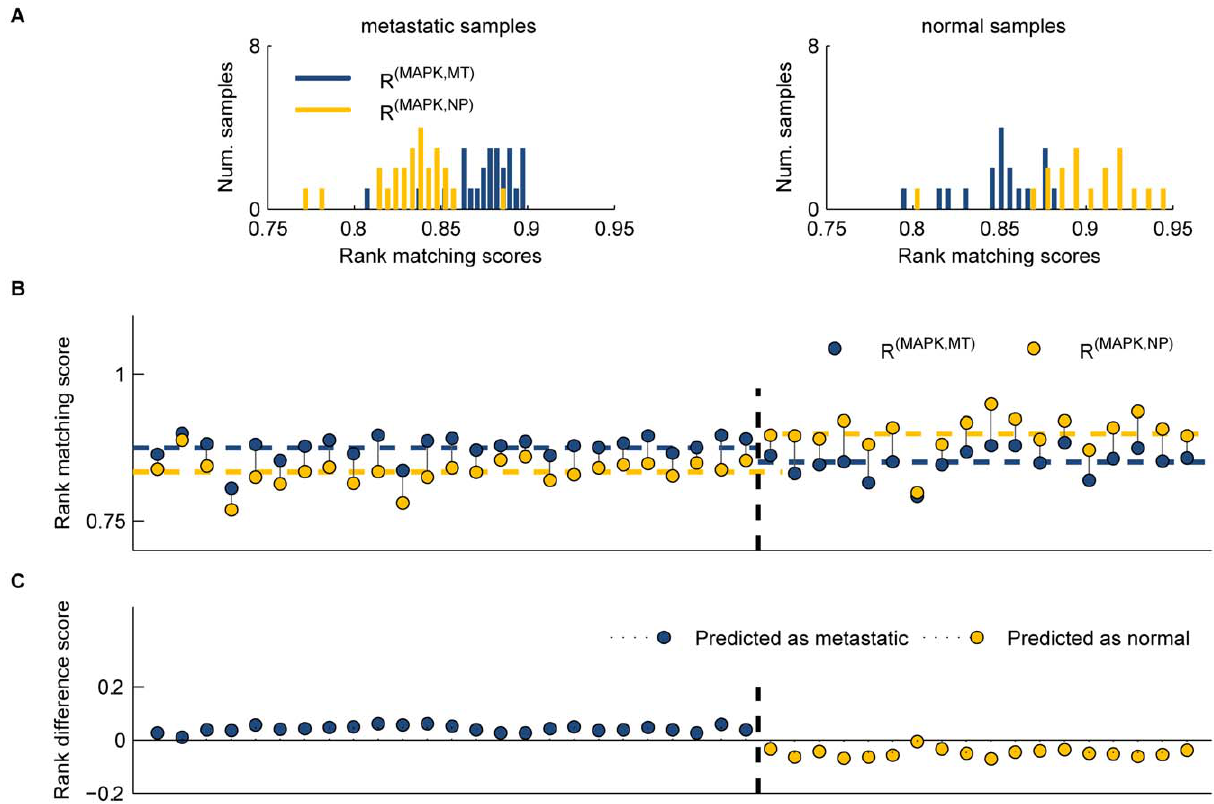
Figure 7. Differential rank conservation of the MAPK network in metastatic prostate cancer and normal prostate. ( A ) Histograms of rank matching scores. MT template matching scores ( R (MAPK,MT) ) are higher on average in MT samples than NP matching scores ( R (MAPK,NP) ). In NP samples, R (MAPK,NP) scores are higher on average than R (MAPK,MT) scores. ( B ) Rank matching scores for the MAPK network. Comparing the two rank matching scores in each sample, MT samples are more similar to the MT template than to the NP template in all cases; NP samples are ranked more similarly to the NP template more than the MT template in all cases. ( C ) Rank difference score values for the MAPK networks. Samples are classified as MT if the rank difference score is greater than zero and as NP if the difference is less than